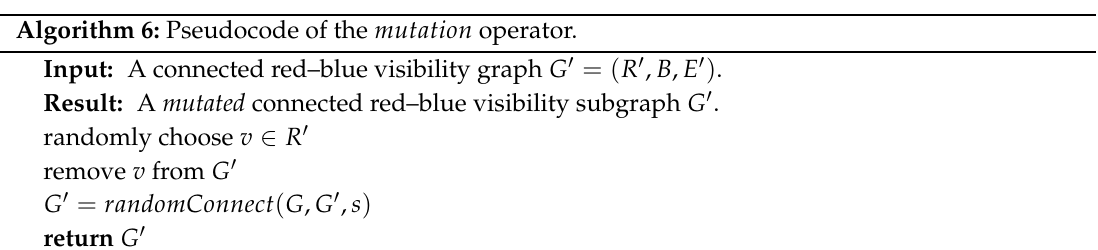
Algorithm 6: Pseudocode of the mutation operator.